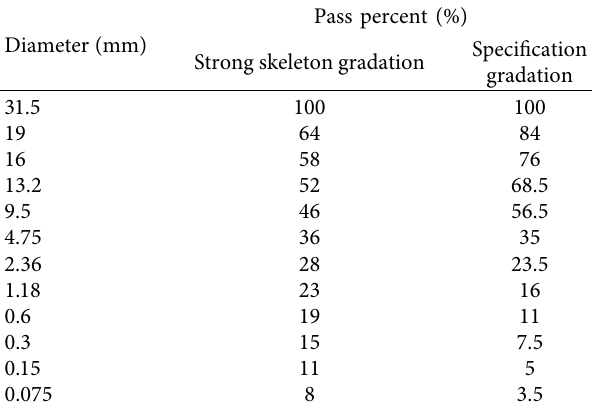
Table 2: Aggregate gradation. Table 3: Physical parameters of unbound granular